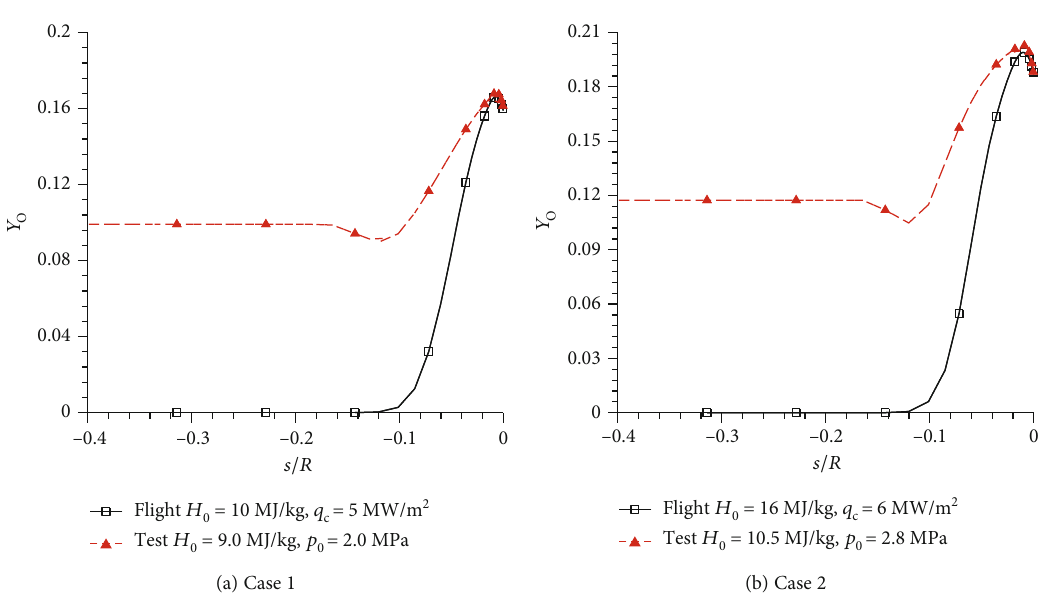
Figure 12: Comparison of the oxygen atom mass fraction on the stagnation